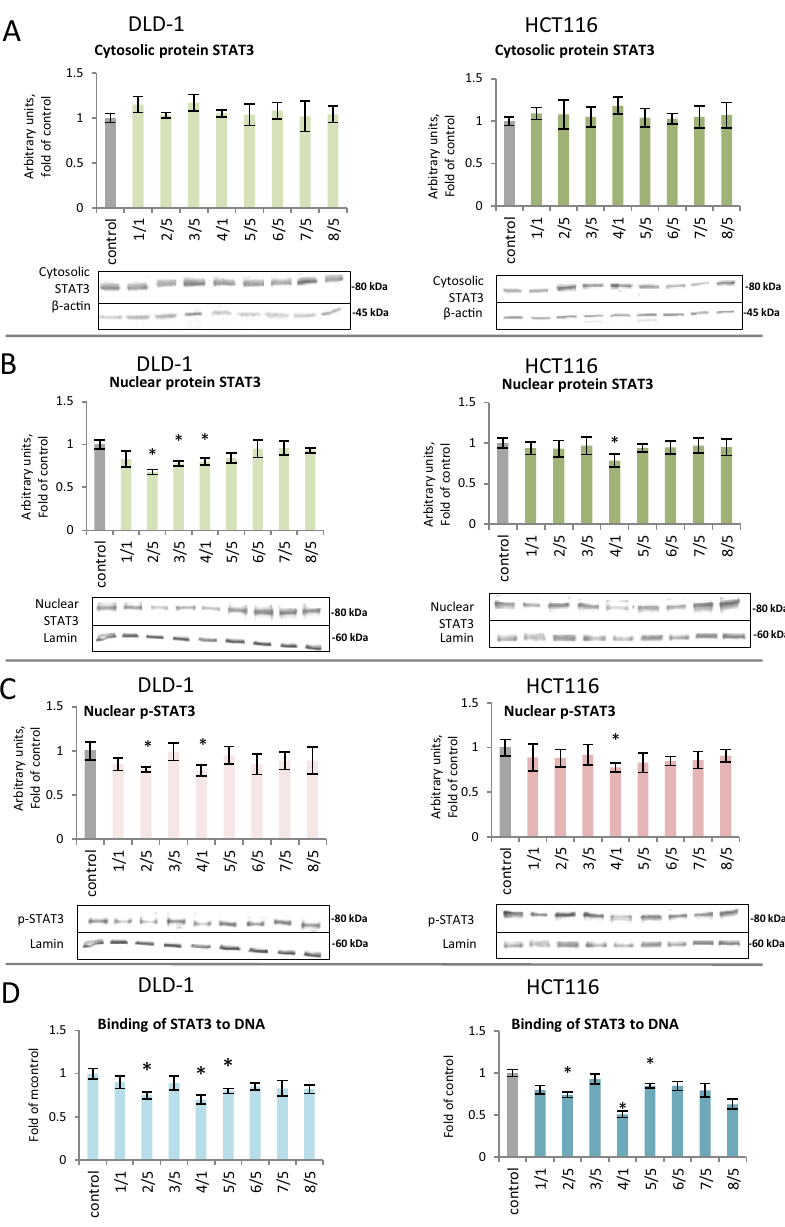
Figure 4. The effect of synthetic thioderivative chalcones compounds on the level of STAT3 activation in DLD-1 and HCT116 cells. ( A) The level of STAT3 protein in the cytosolic fraction. ( B) The level of STAT3 protein in the nuclear fraction. ( C) The level of p-STAT3 protein in the nuclear fraction. Representative Western immunoblots are presented under the graphs ( A–C ). ( D) The level of STAT3 binding to DNA. The values (mean ± SEM) were calculated as a relative change in transcript or protein level in comparison to control cells (where control expression equals 1). The values from three separate experiments run in triplicate are presented. Asterisk: mean values were significantly different from the control group (p ≤ 0.05). Original scans of blots are shown in Supplementary Fig.